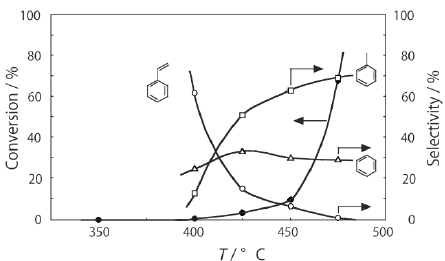
Figure 3. Effect of temperature on reactivity and selectivity in reductive dealkylation